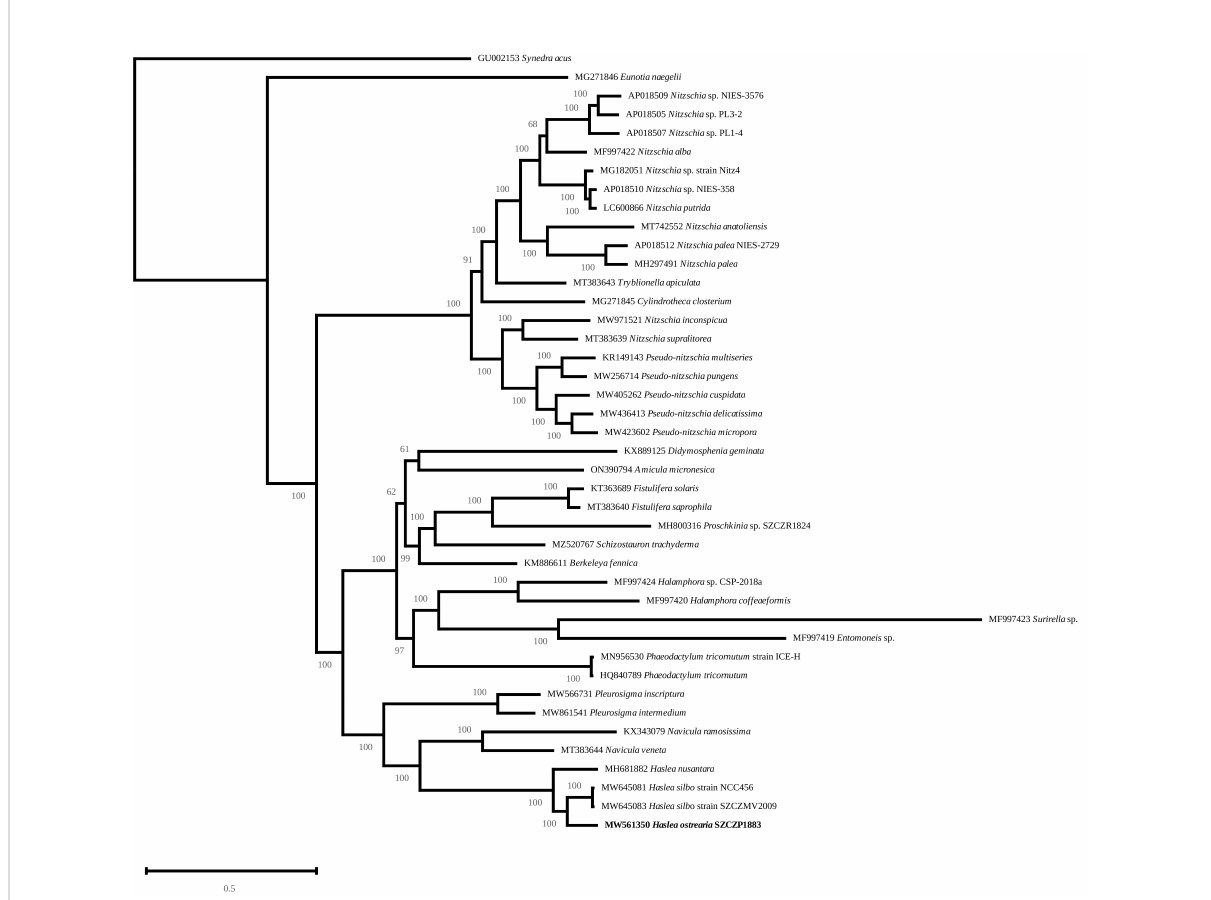
FIGURE 9 Maximum Likelihood phylogenetic tree inferred from an alignment of all protein coding genes from the mitogenomes of 42 taxa of diatoms and rooted with Synedra acus (Log-likelihood: -504283.7367). The scale indicates the number of substitutions per